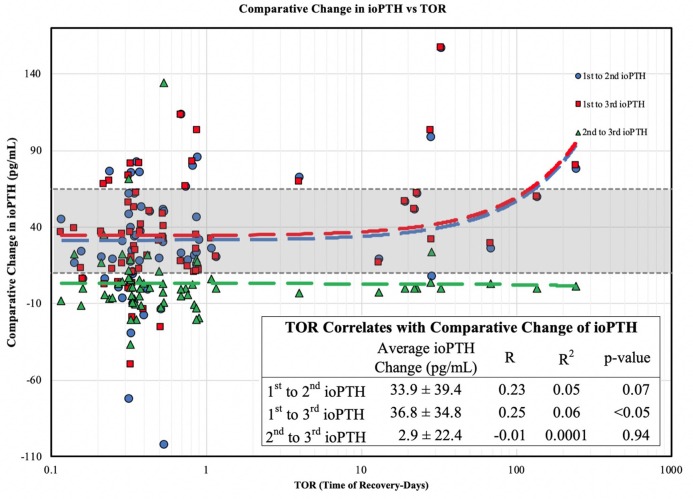
Comparative change in ioPTH vs. TOR. The change (delta) between the 1st and 3rd ioPTH correlates with parathyroid gland recovery.